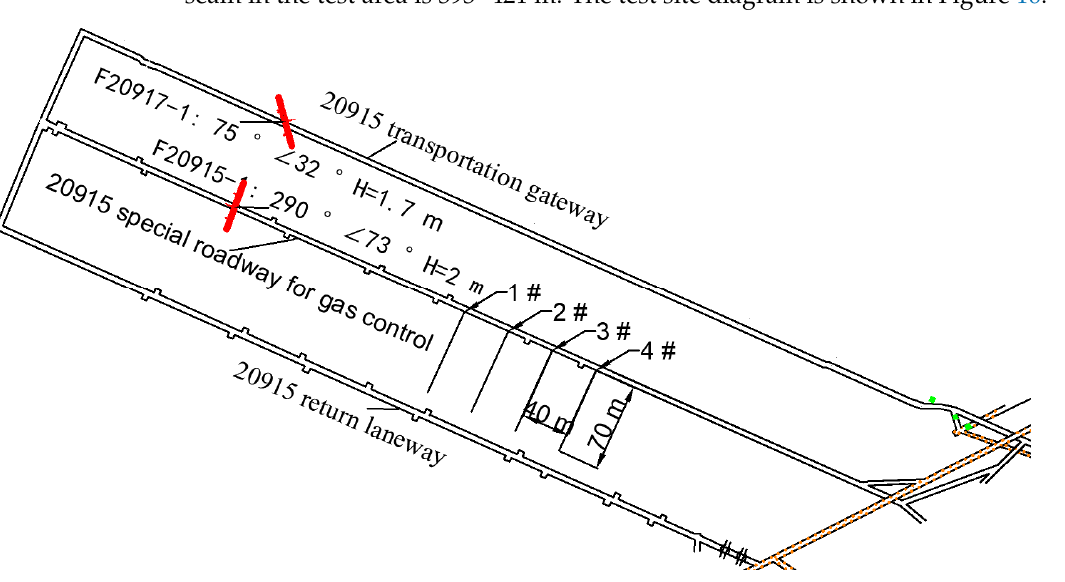
Table 2. Drilling